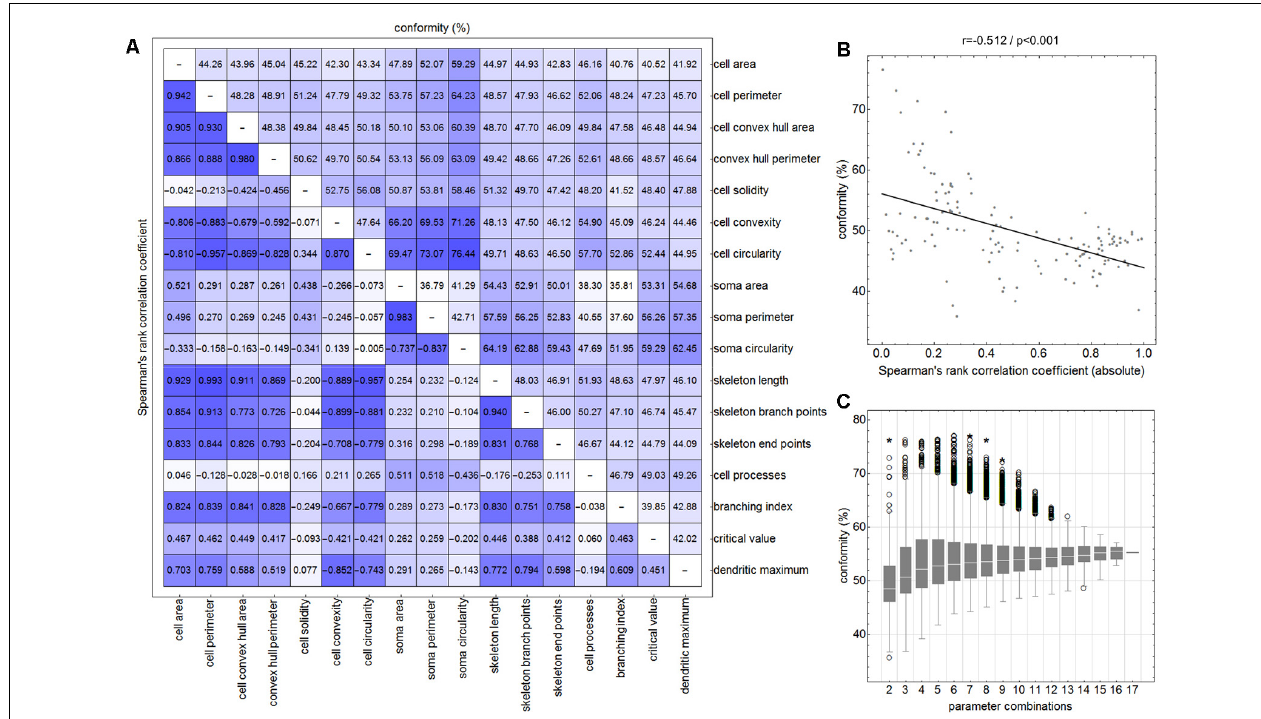
FIGURE 5 | Degree of conformity (CNN vs. NC classification; upper triangular matrix) and correlation coefficients (correlation for the distribution of all cell’s parameter points within the parameter space; lower triangular matrix) of all two-parameter combinations (A) . Linear regression analysis between the degree of conformity (CNN vs. NC classification) and the absolute correlation coefficient (distribution of all cell’s parameter points within the parameter space) for all two-parameter combinations (B) . Ranges of conformity values for 2–17 parameter combinations (C) . Circles represent outliers and asterisks represent extreme values.